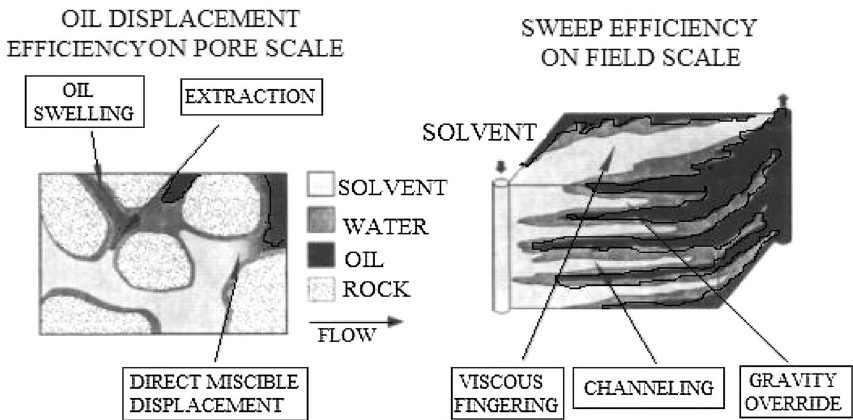
Fig. 3 Factors affecting misci- ble recovery to improve quality. Reproduced with permission from Healy et al.